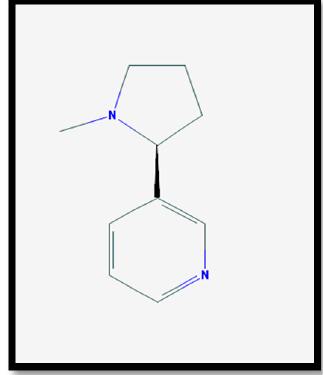
Figure 1. The chemical structure of nicotine [23].